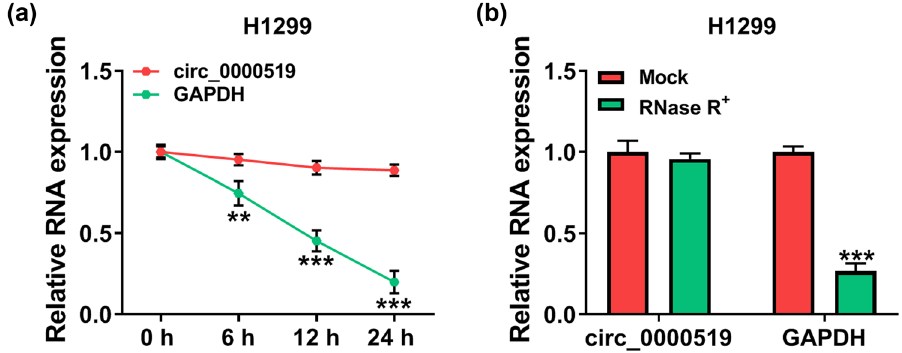
Figure A1: The circular structure of circ_0000519 was identi fi ed by Actinomycin D and RNase R treatment assays. ** P < 0.01, and *** P <